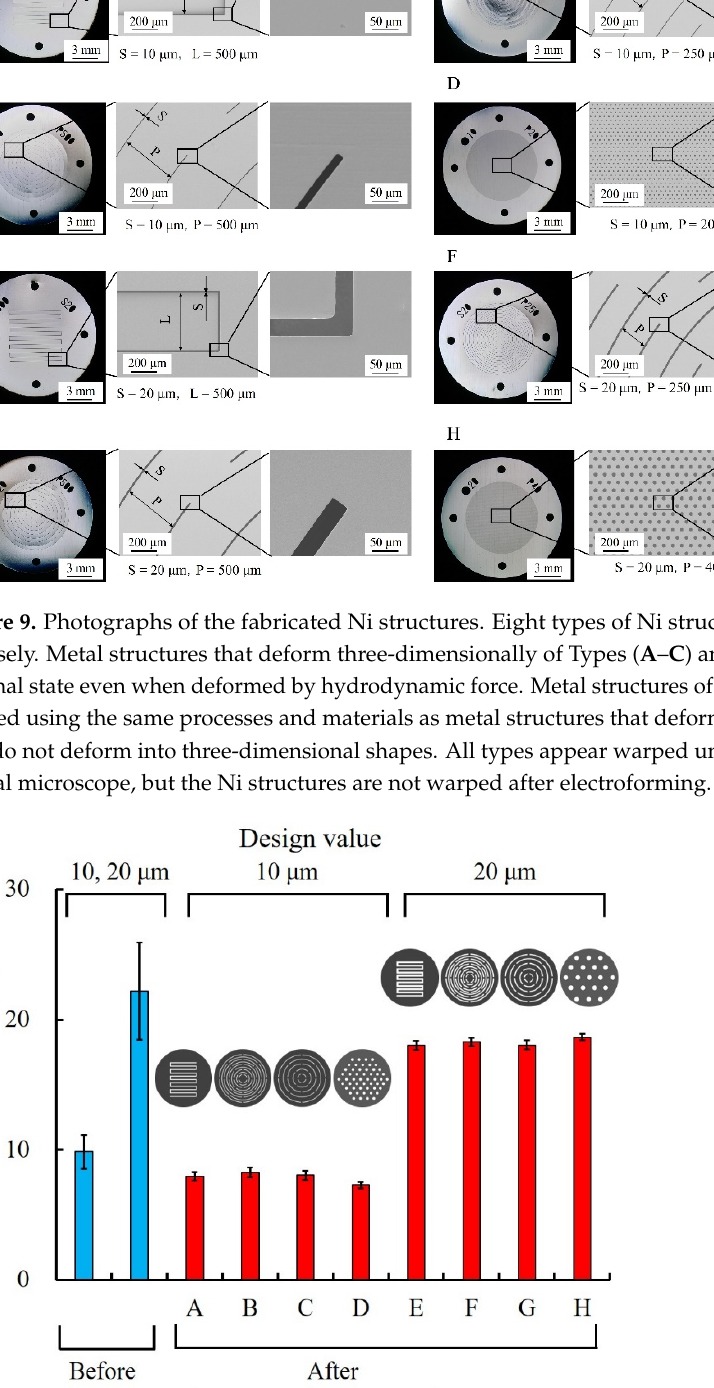
Figure 10. Metal-structure slit-width dimensions before and after improvement of the photolithog- raphy process. The dimensional variation decreases from σ = 3.74 to σ = 0.25 µm as a result of optimizing the photolithography conditions. The desired slit width is expected if the design value is adjusted.